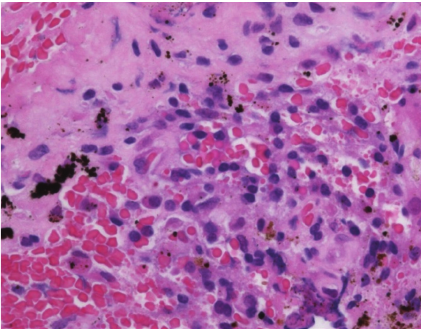
Figure 5: Histological examination showing the metal debris, histiocytes containing metal particles, but no obvious sign of acute